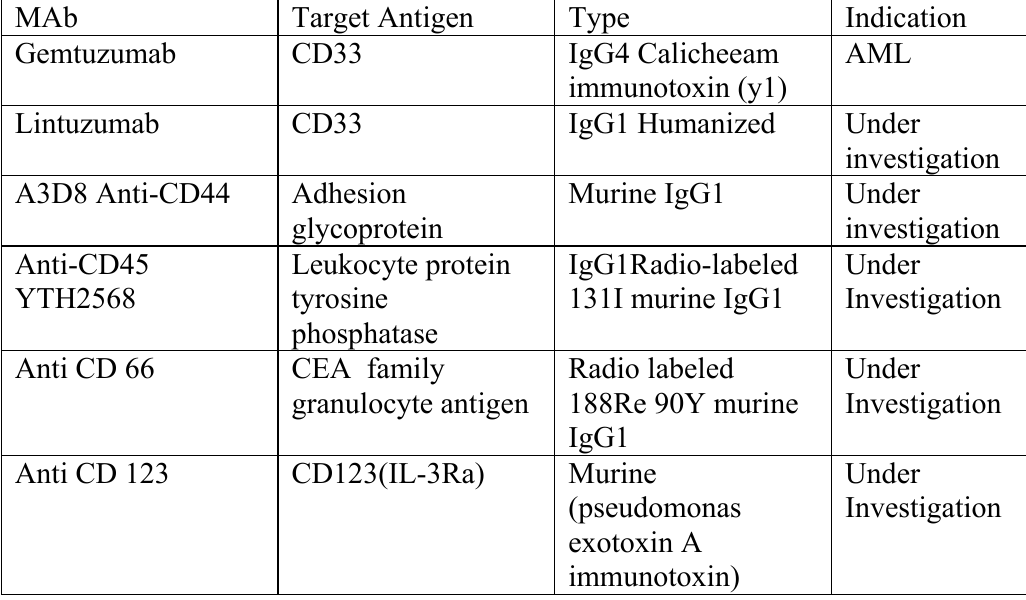
Table 2. Monoclonal antibodies targeting myeloid